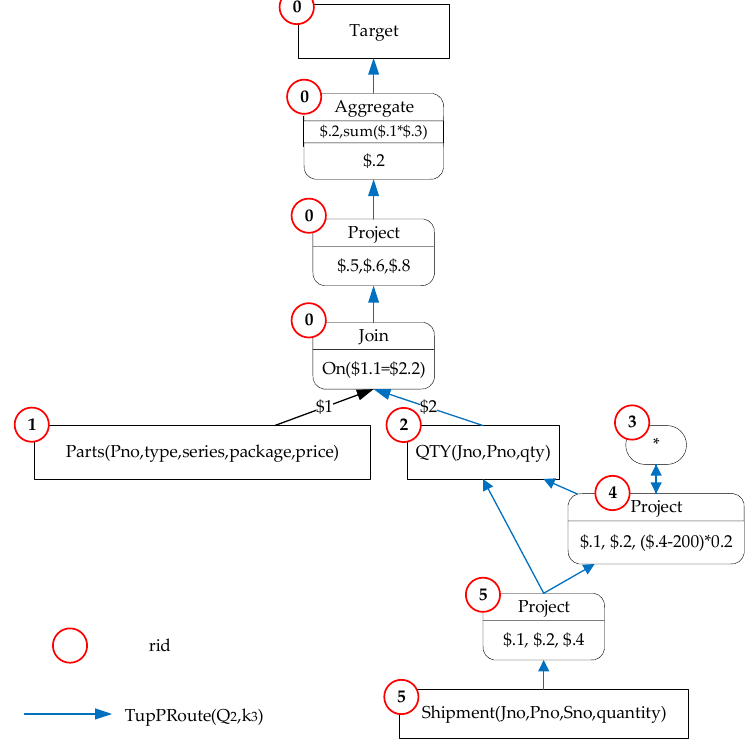
Figure 7. SPGraph and TupPRoute of the query 𝑄 (cid:2870) .